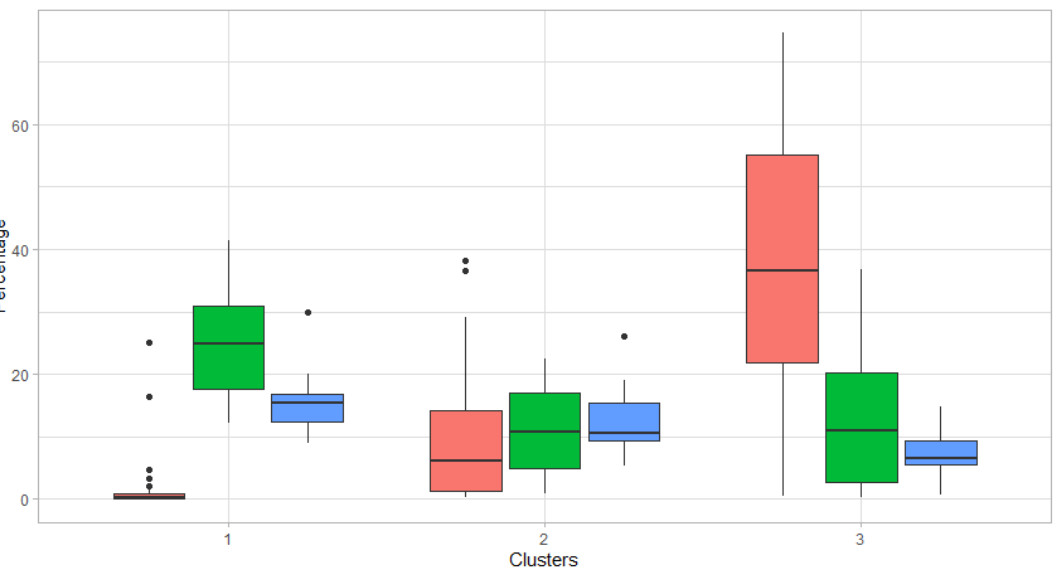
Figure 6. Share of manufacturing, trade, and services, mining in gross value added by cluster in